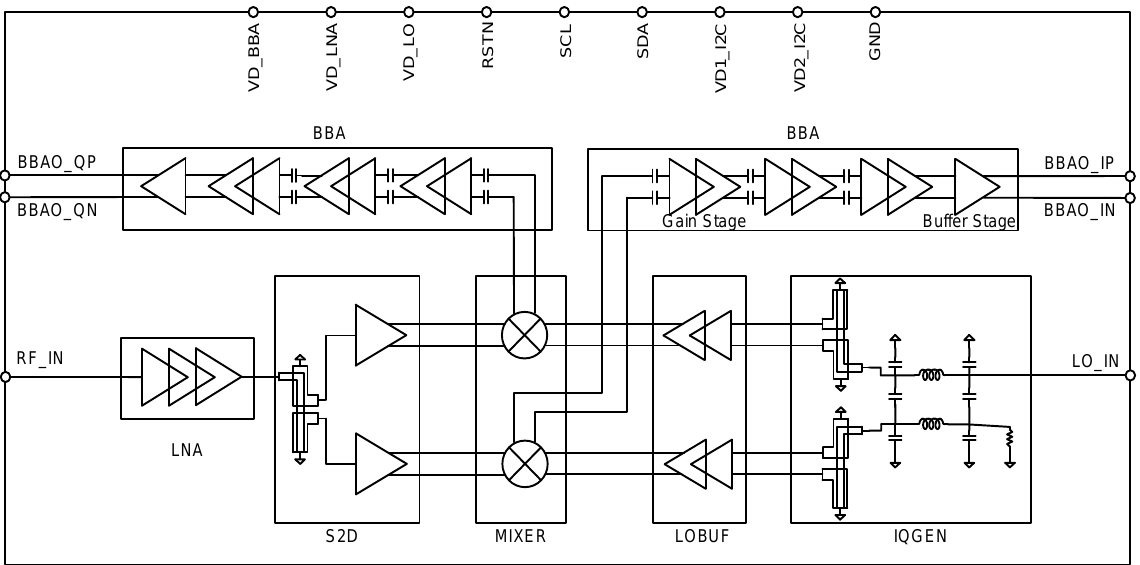
Figure 1. Block diagram of proposed 60 GHz CMOS I/Q receiver.